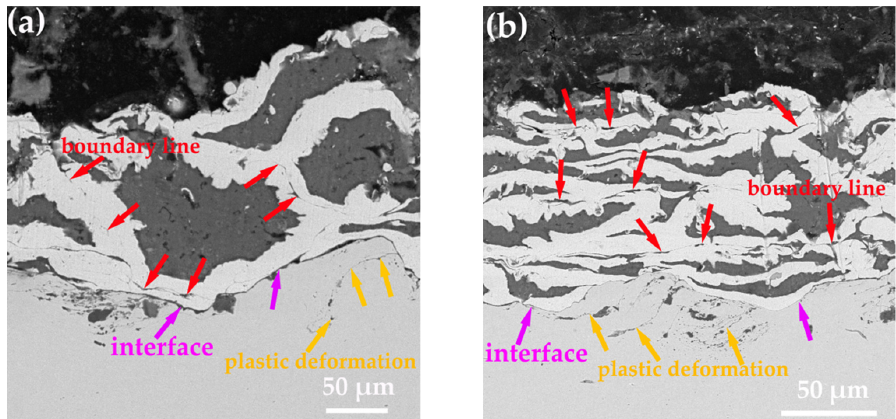
Figure 9. Cross-section morphologies of Ni-coated Al coatings deposited onto a Q235 steel substrate at an accelerating gas temperature of ( a ) 200 °C and ( b ) 400 °C .